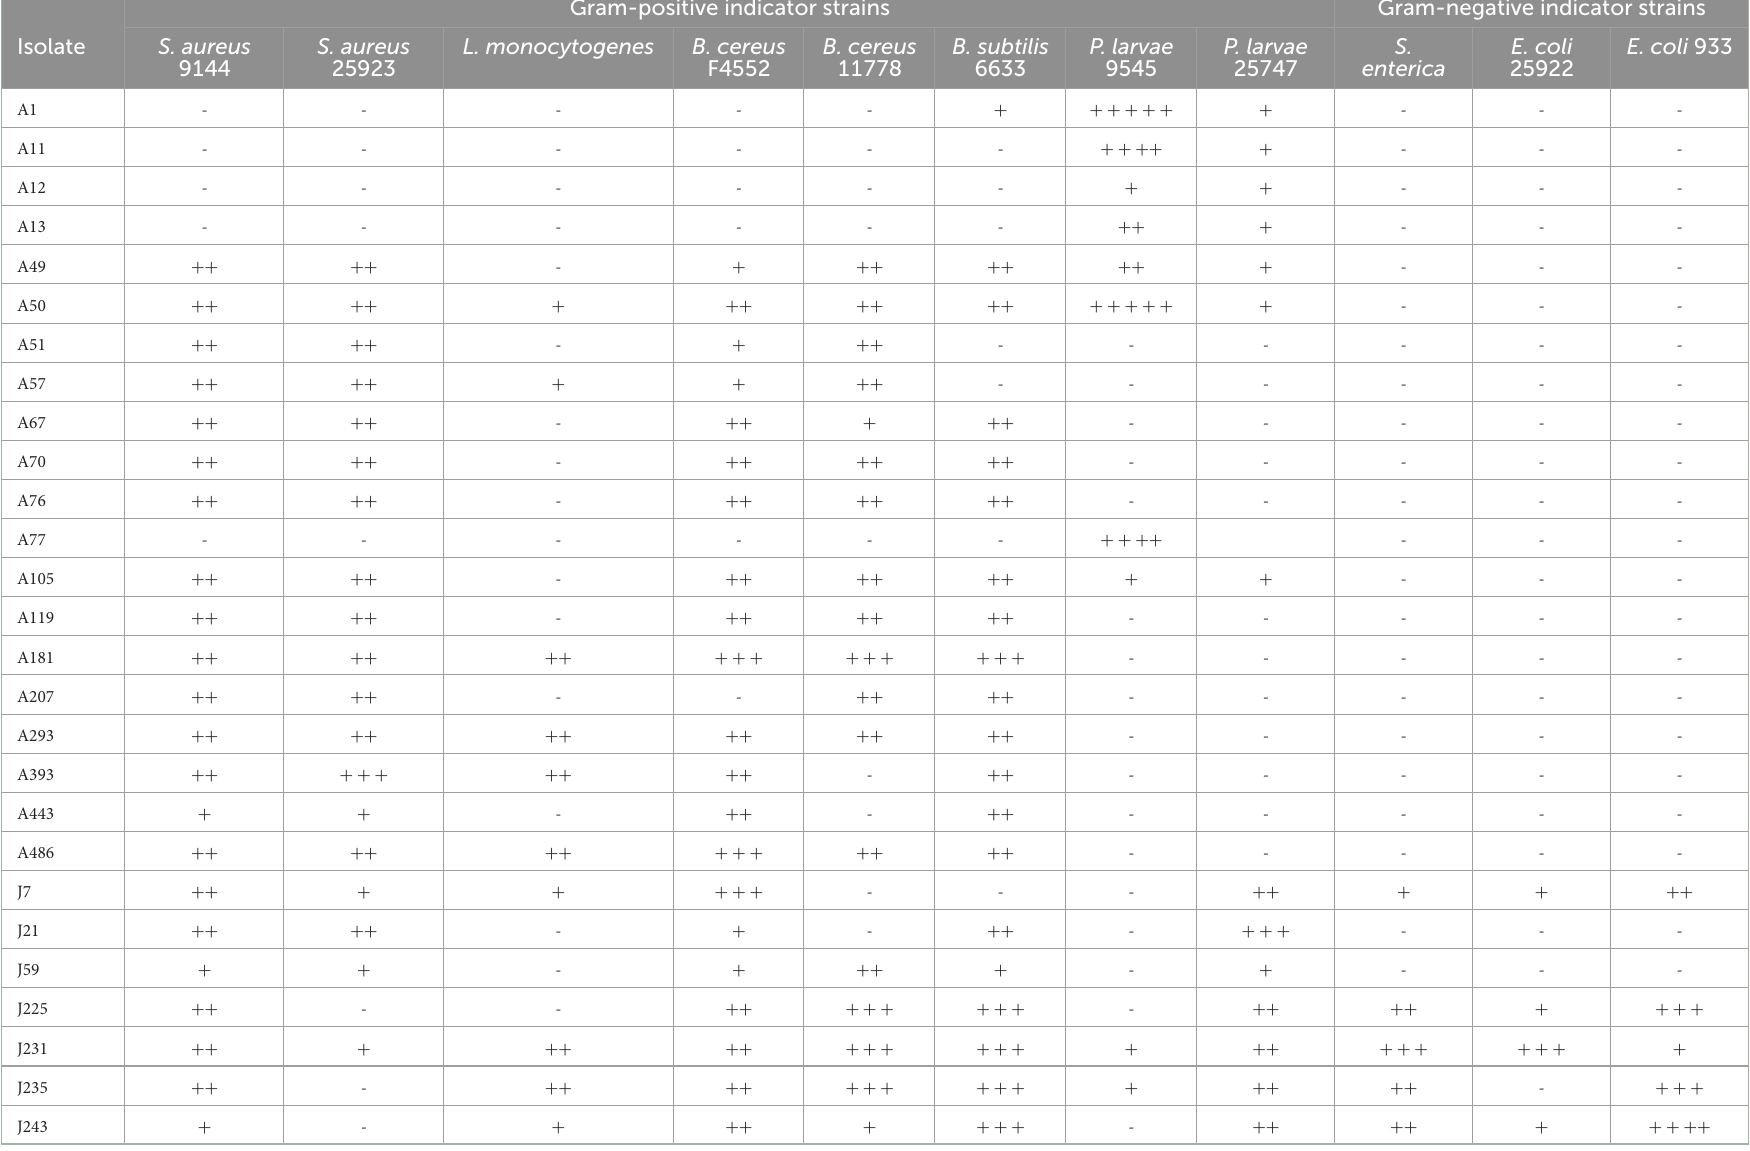
TABLE 3 The spectrum of antibacterial activity of isolates from April (A), June (J), and September (S) honey stomachs and August hive honey